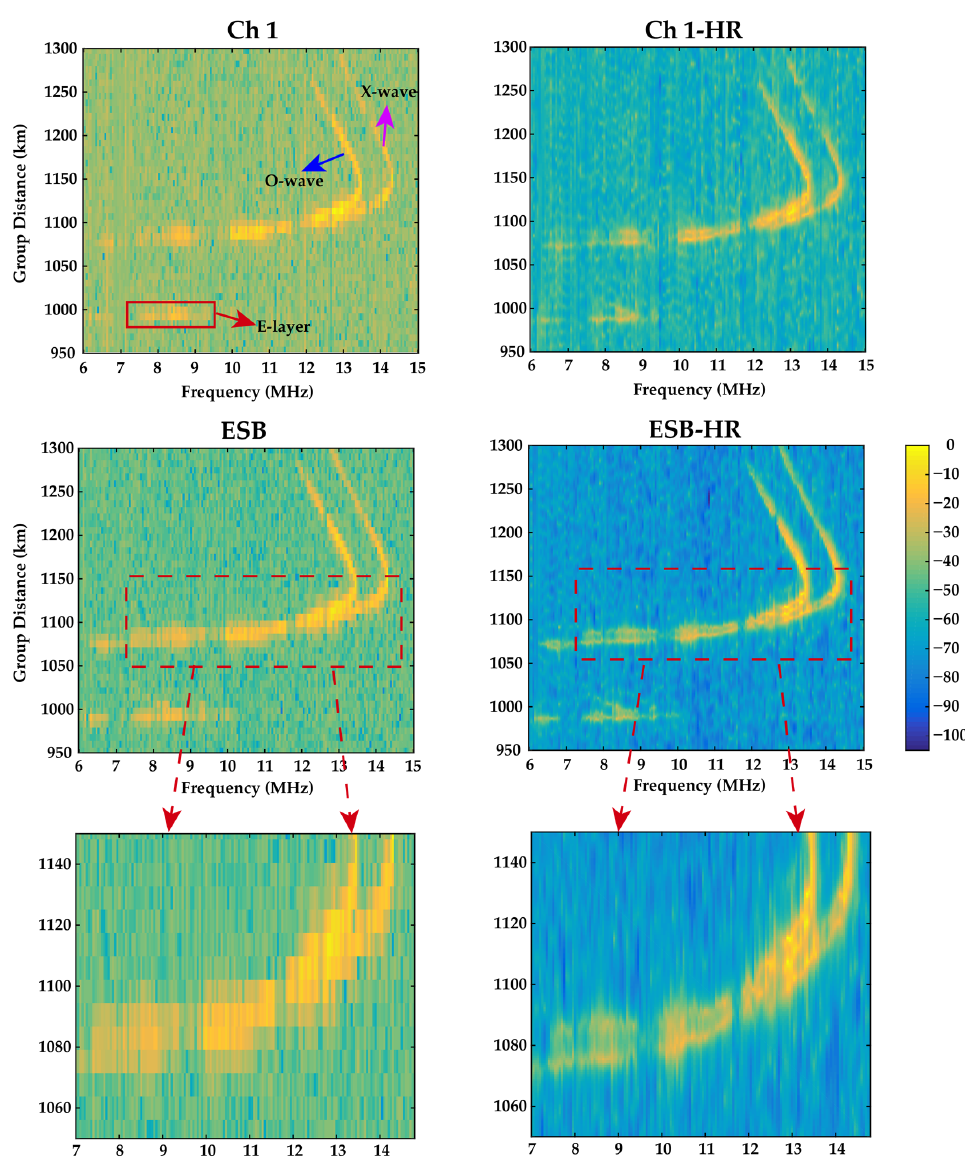
Figure 16. Comparison of OIS signal of 6~15 MHz swept frequency processed by different algo- rithms.